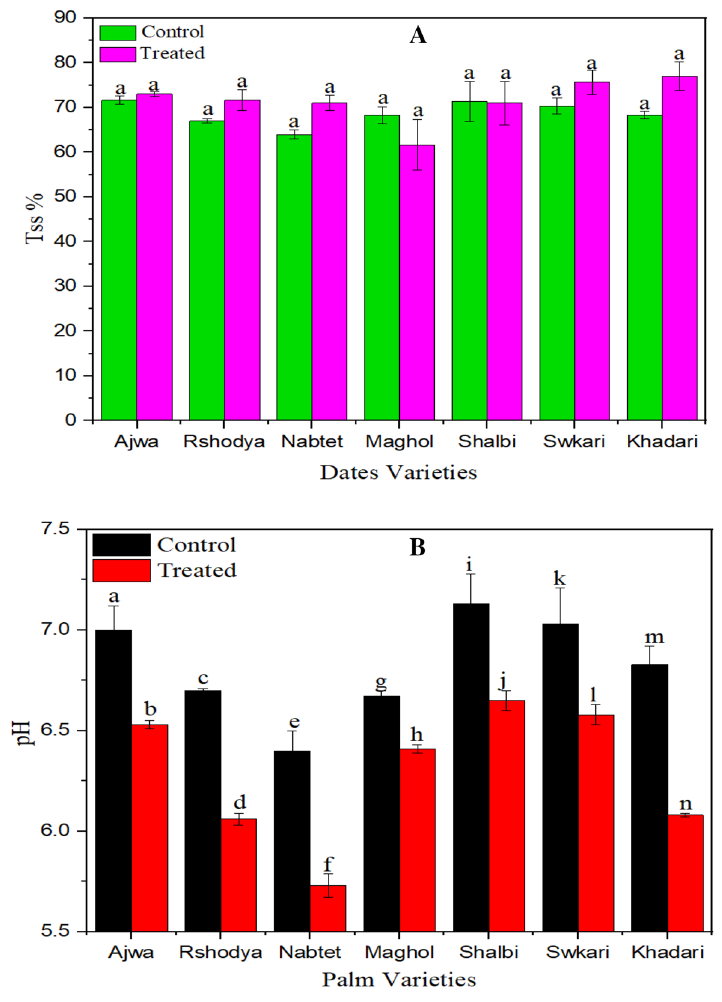
Figure 5. The influence of SDBD on TSS, P value = 0.70 ( A ), and pH, P value = 0.00 ( B ) of Palm dates